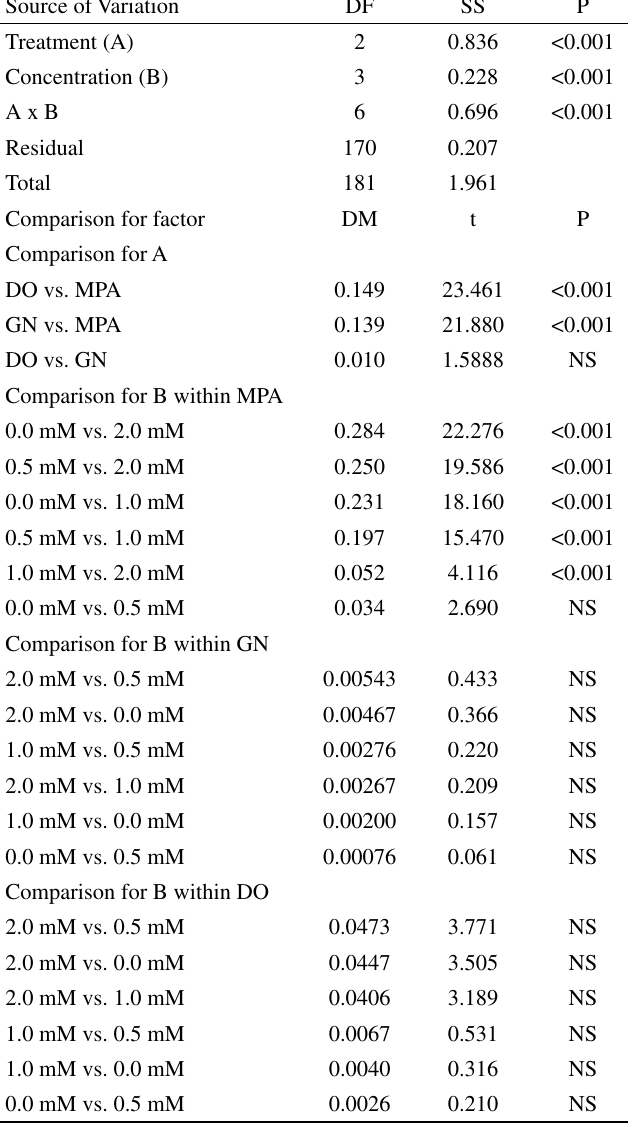
Table 4 - Two-way factorial analysis of variance of Δ Em caused